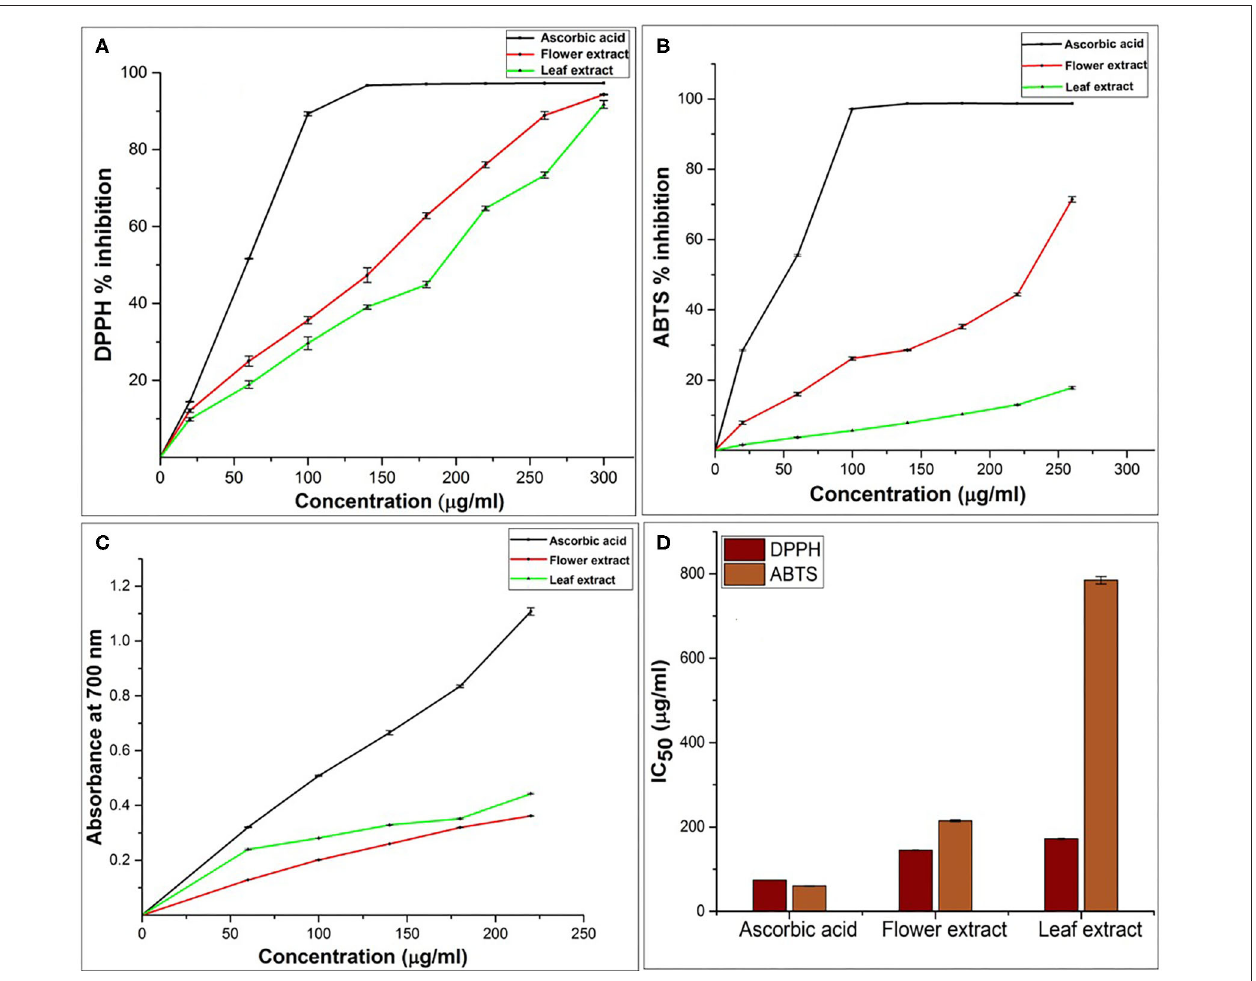
FIGURE 2 | Antioxidant activity of L. camara LE and FE. (A) DPPH radical scavenging activities (B) ABTS radical scavenging activity leaf and flower extract at different concentrations. (C) Ferric reducing capacity. (D) Radical scavenging activity of L. camara extract in term of IC 50 . Values represented as mean ± SD ( n = 3, P <